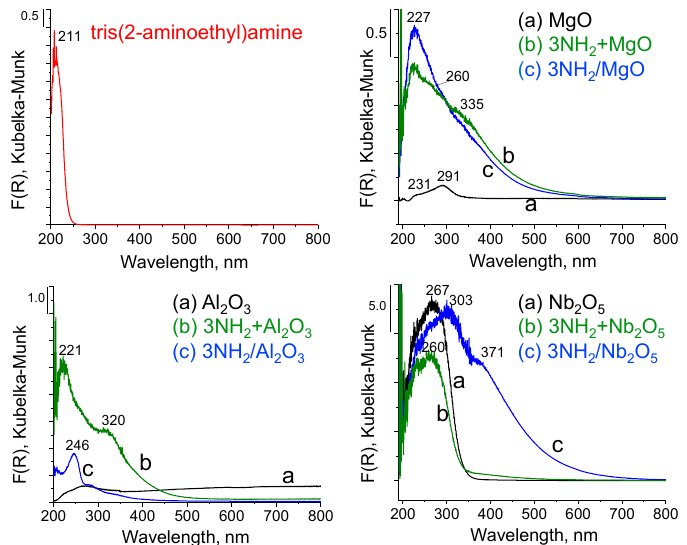
Figure 5. UV–VIS spectra of tris(2-aminoethyl)amine, metal oxide supports and modified samples.